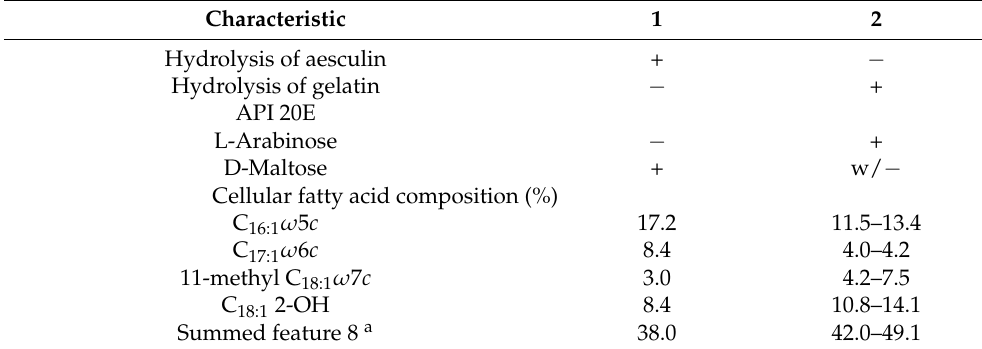
Table 1. Differential characteristics of Iodidimonas muriae and Iodidimonas gelatinilytica ; Strains: 1, Iodidimonas muriae ; 2, Iodidimonas gelatinilytica . +, Positive; w, weakly positive; − , negative. Characteristic 1 2 Hydrolysis of aesculin + − Hydrolysis of gelatin − + API 20E L-Arabinose − + D-Maltose + w/ − Cellular fatty acid composition (%) C 16:1 ω 5 c 17.2 11.5–13.4 C 17:1 ω 6 c 8.4 4.0–4.2 11-methyl C 18:1 ω 7